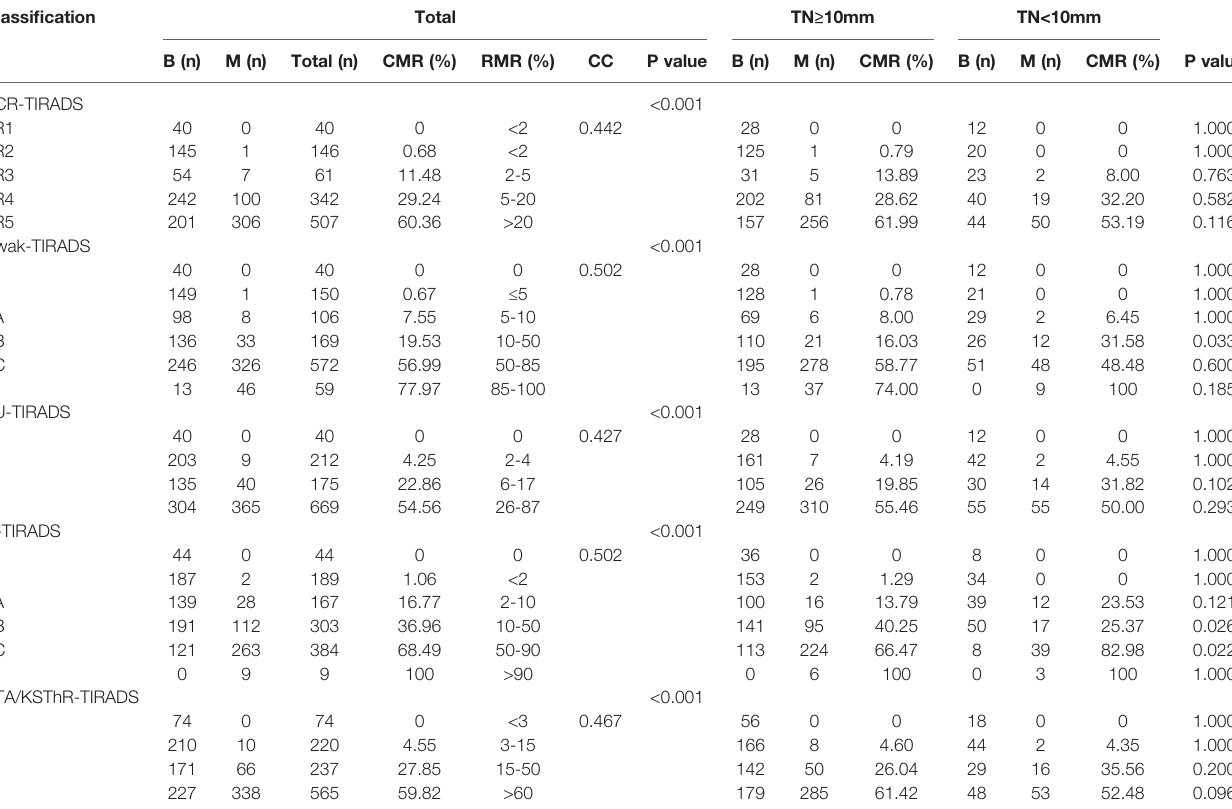
TABLE 2 | Malignancy rates in ACR-TIRADS,Kwak-TIRADS,EU-TIRADS, C-TIRADS, KTA/KSThR-TIRADS. Classi fi cation Total TN ≥ 10mm